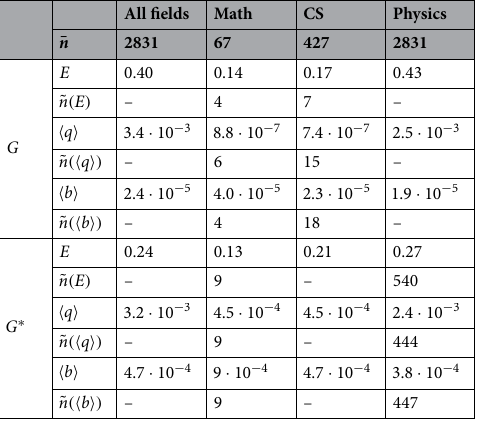
Table 5. Maturation indices and maturation values of the graphs’ centrality and efficiency indicators. All notations and definitions are reported in the text. The symbol “–” reflects the fact that the property does not maturate, implying that significant changes in the property’s value occur at all fusion indices, up to the final layer (the reported values are therefore the “asymptotic” ones obtained by fusing all